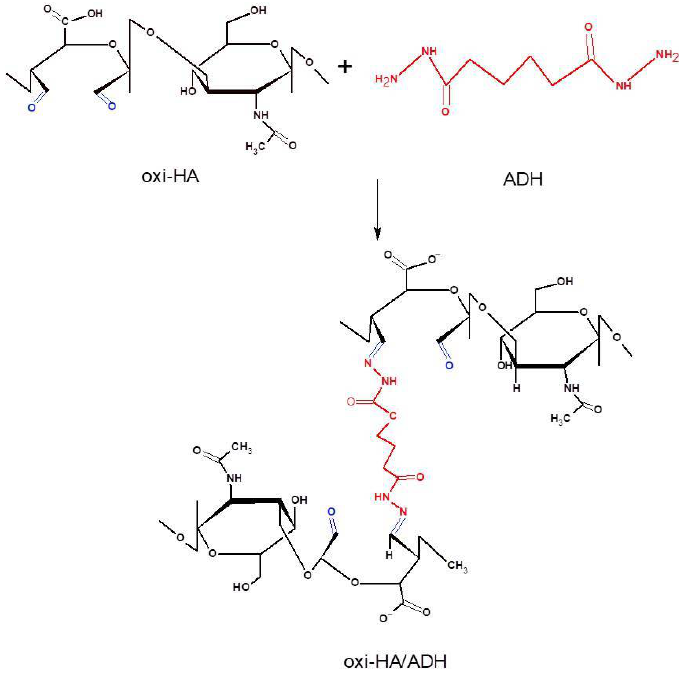
Figure 4. Chemical cross-linking reactions of oxidized hyaluronic acid (oxi-HA in black with aldehyde groups in blue) cross-linking with adipic dihydrazide (ADH in red) to form the oxi-HA/ADH hydrogel.